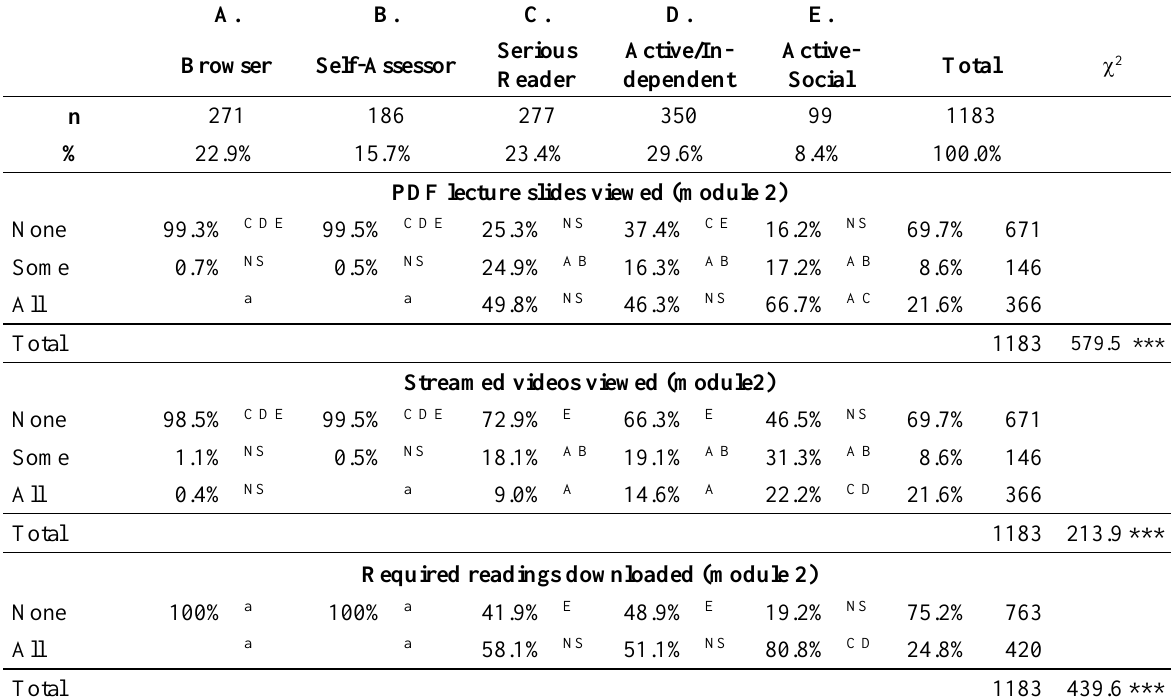
Engagement Profile Based on Learners’ Behavioural Engagement